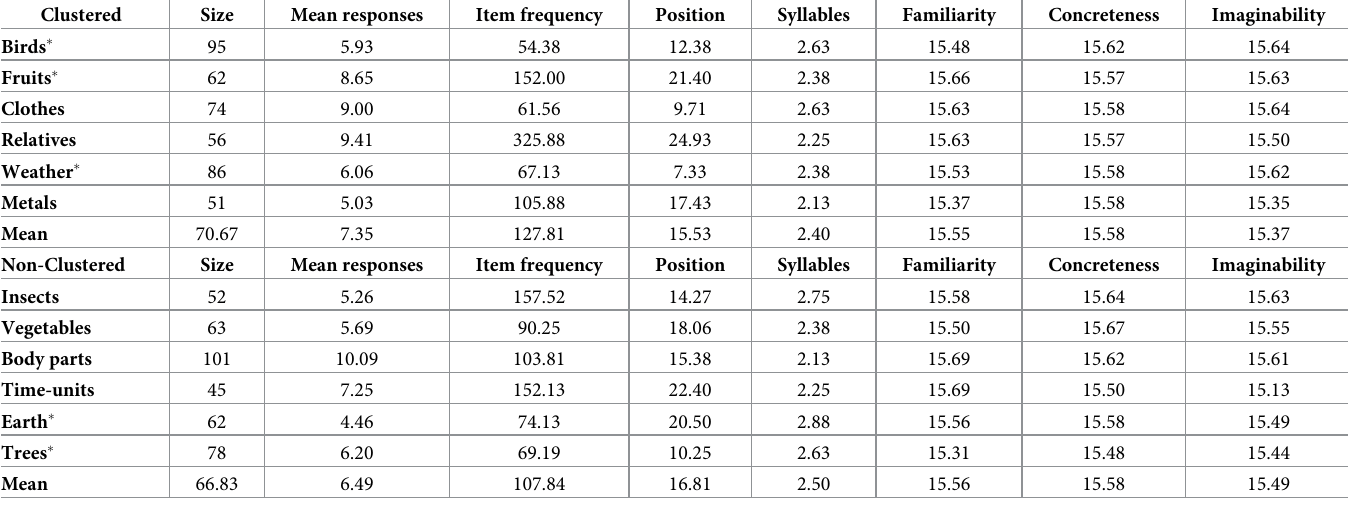
Table 1. Category size, mean responses produced in the category, and mean frequency, first position, number of syllables, familiarity, concreteness, and imaginabil- ity of the items included in each of the categories in the clustered and the non-clustered versions of the conceptual Span